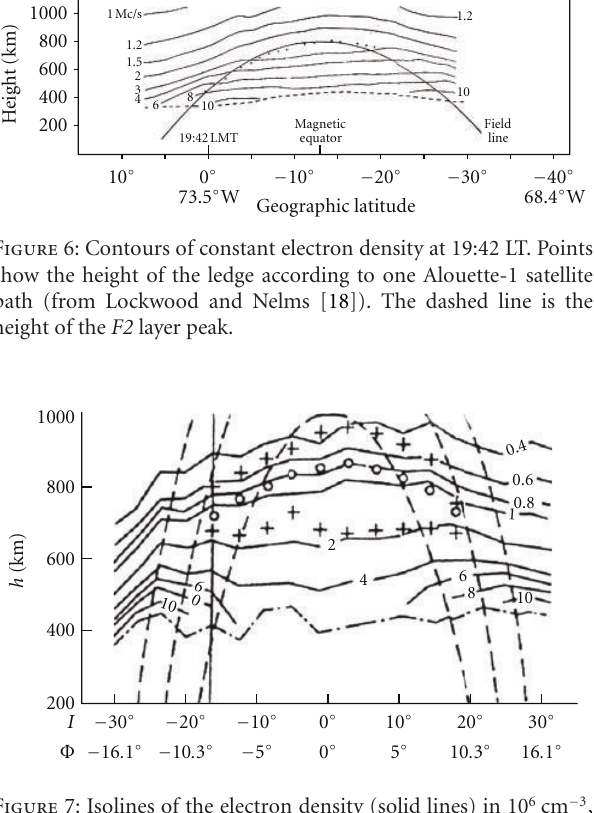
Figure 7: Isolines of the electron density (solid lines) in 10 6 cm − 3 , plotted according to the data of outer sensing of the ionosphere at the turn of 2333 June 5, 1987. Dash-dotted line shows h m F2 , dashed lines: the geomagnetic field lines with tops at 1000, 1500, and 2000 km, the vertical line marks the position of the geographic equator, crosses show the upper and lower limits of the stratifica- tion, triangles: the upper limit of the stratification above the satellite altitude, circles: position of the maximum of ionization ledge. (from Prutensky,